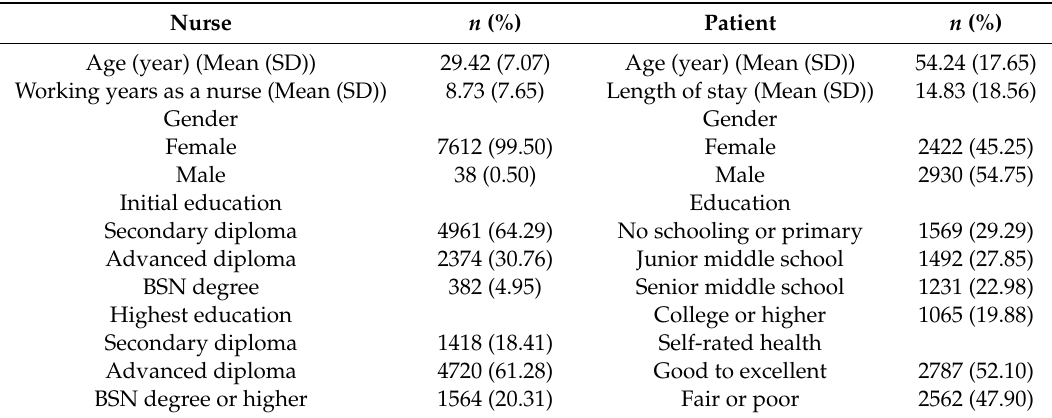
Table 1. Demographics of nurse ( n = 7802) and Patient ( n =